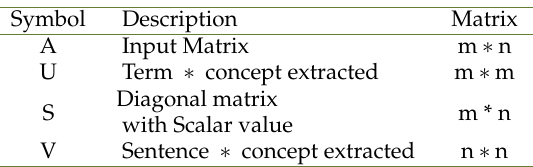
Table 1. Different